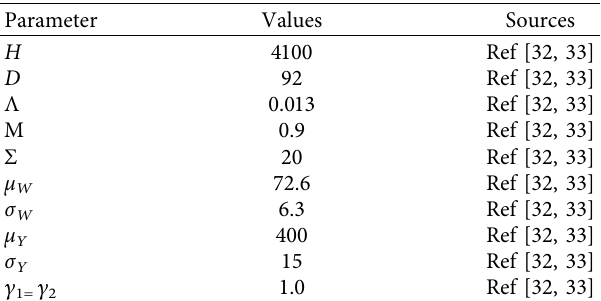
Figure 10: Sensitivity analysis of R ( t ) on D . Figure 11: Sensitivity analysis of R ( t ) on λ . Table 4: Parameter values of the Wiener process and Poisson